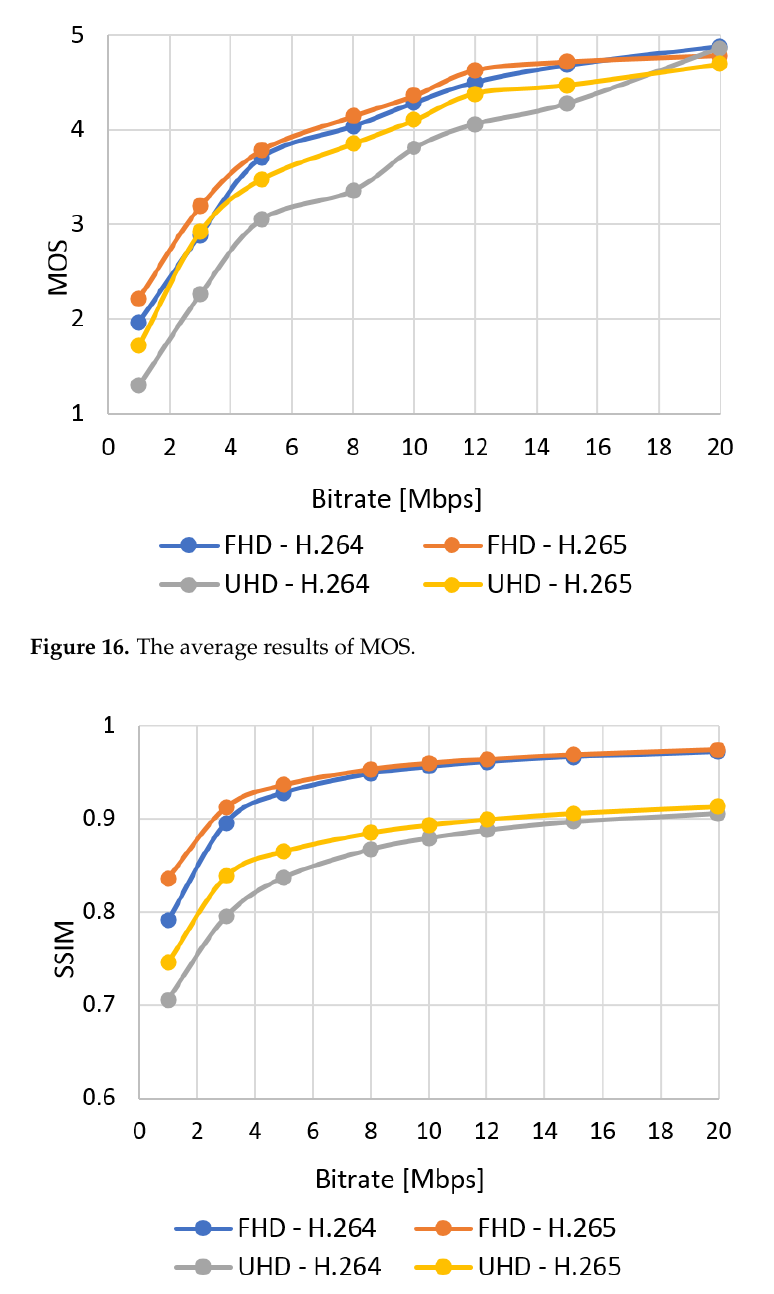
Figure 17. The average results of